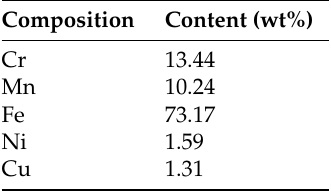
Figure 2. Schematic of experimental set up and pattern definition of MEJM. Table 2. Chemical composition of